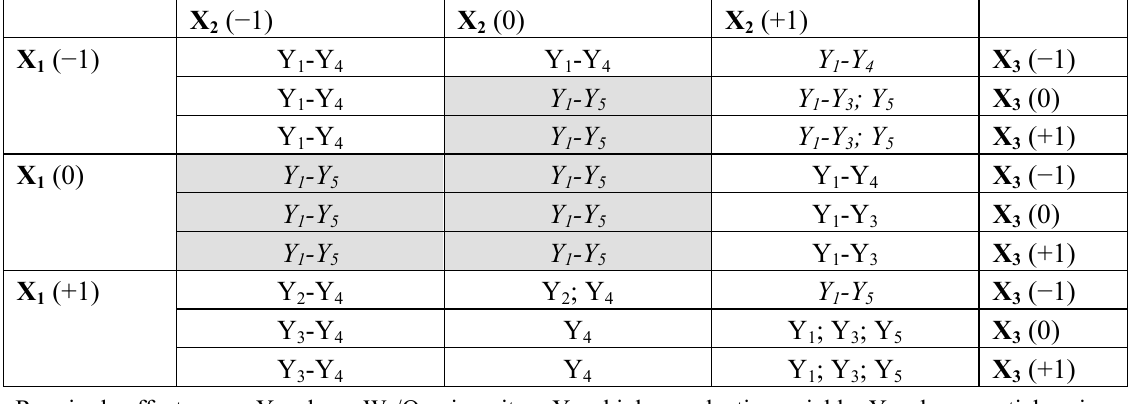
Table 5. Optimization of levels of independent variables according to required